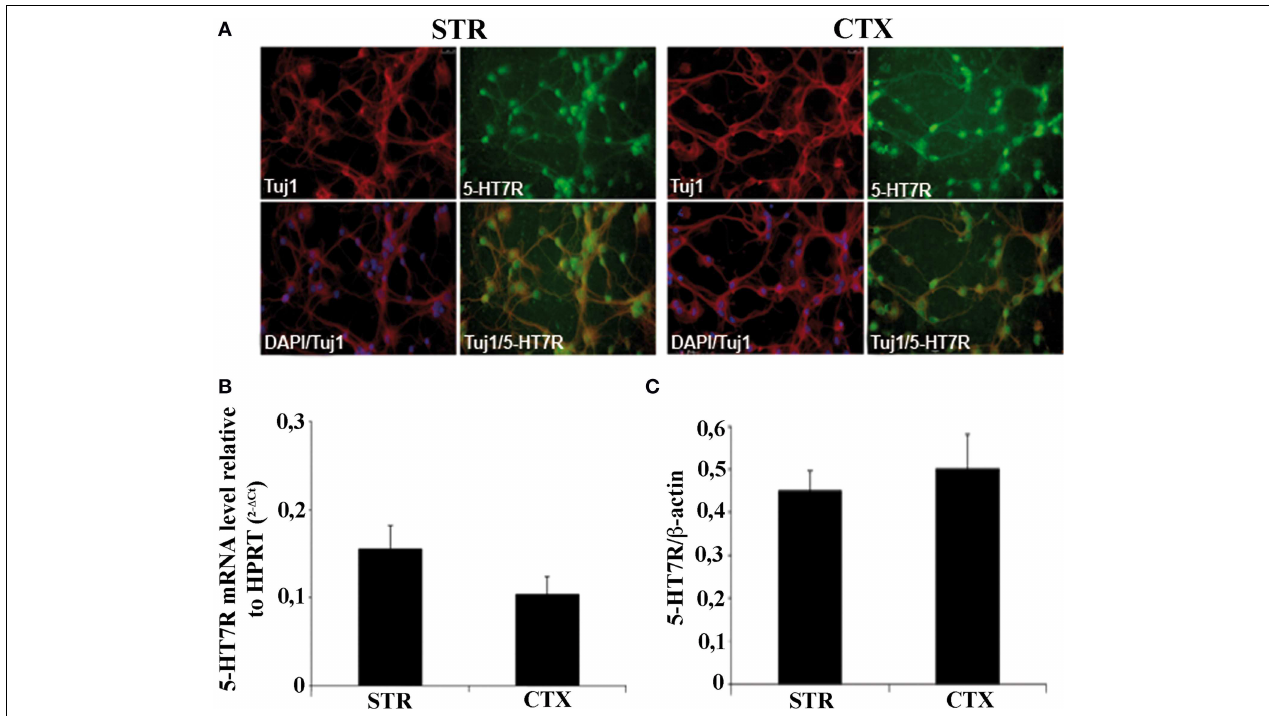
levels normalized with those of the housekeeping gene HPRT (means ± SEM; n = 3 ). (C) Quantitation of 5-HT7R protein in neuronal cultures. The bars represent the densitometric values of 5-HT7R Western blot signals normalized with those of β -actin signals in the same samples (mean ± SEM; n = 3 ). STR: cultures from the striatal complex of E15 mouse embryos; CTX: cultures from the cortex of E15 mouse